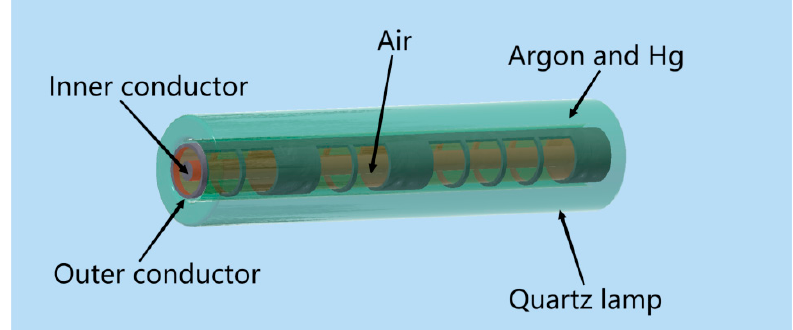
Figure 1. Diagram of slotted coaxial waveguide.